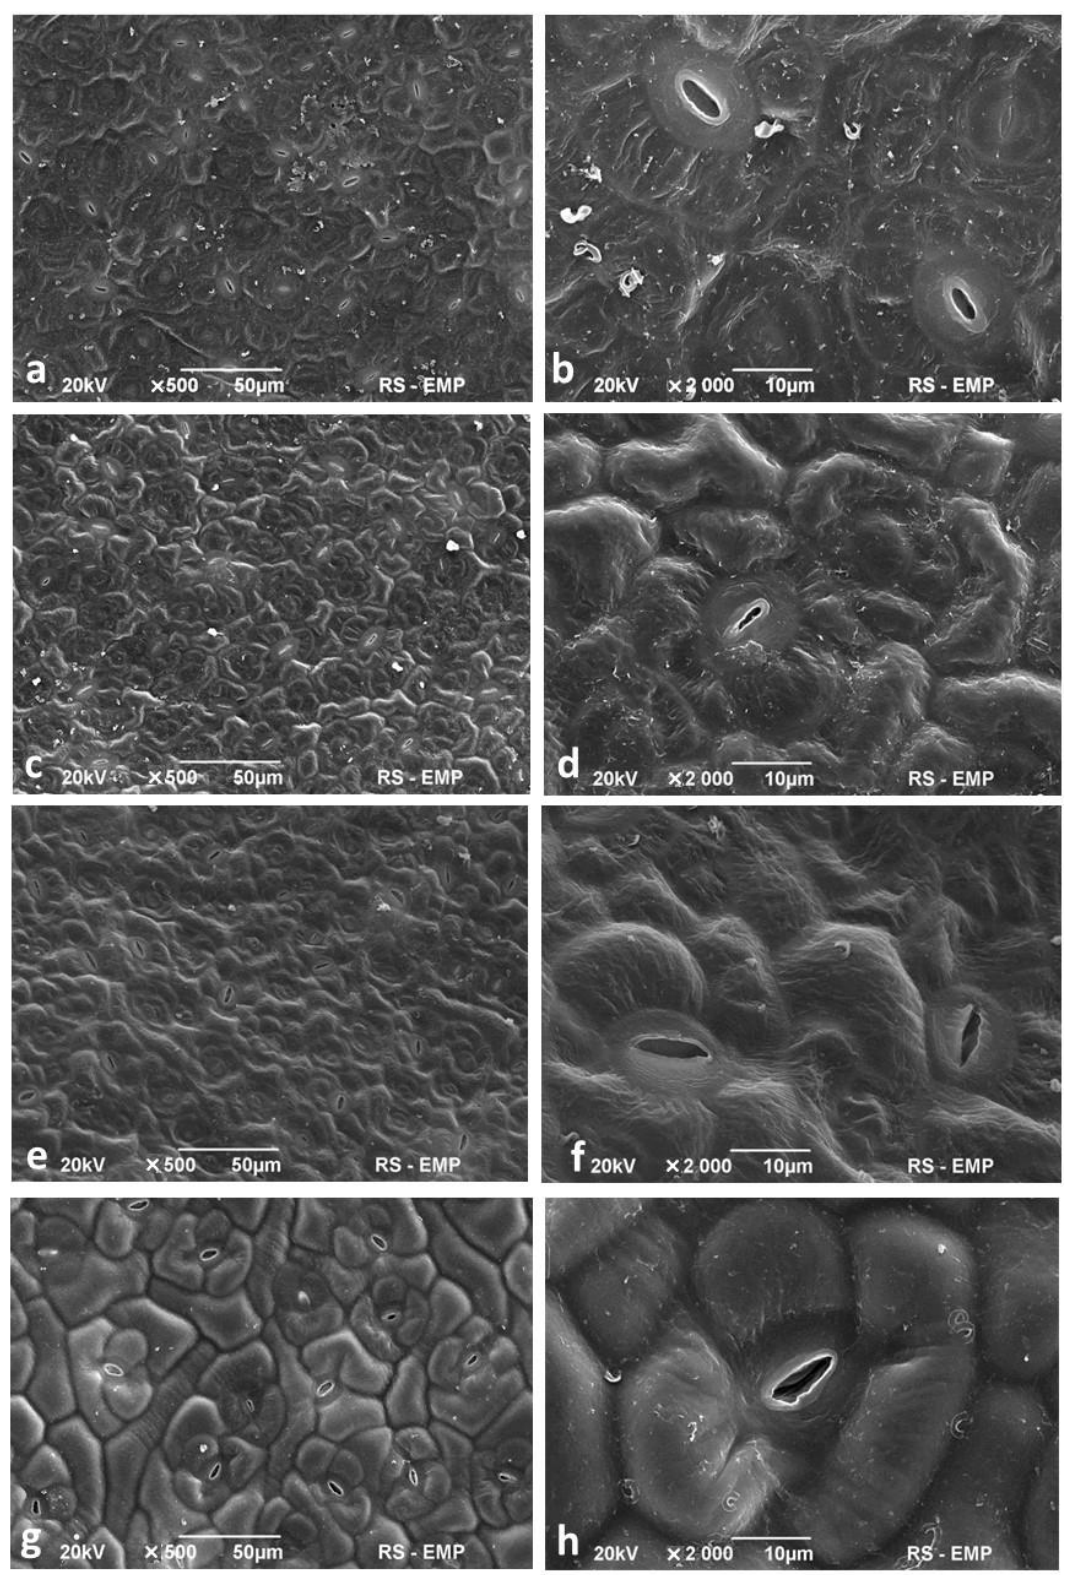
Figure 3. Scanning electron micrograph of the abaxial epidermis. ( a , b ) kale cultivar “Redbor”, ( c , d ) kale cultivar “Starbor”, ( e , f ) savoy cabbage “Gloriosa”, ( g , h ) savoy cabbage “Alcosa”. Stomata cells in Brassica are anisocytic, meaning stomata are surrounded by three cells, one of which is usually smaller than the other two (Figure 4a–d). In both species, the